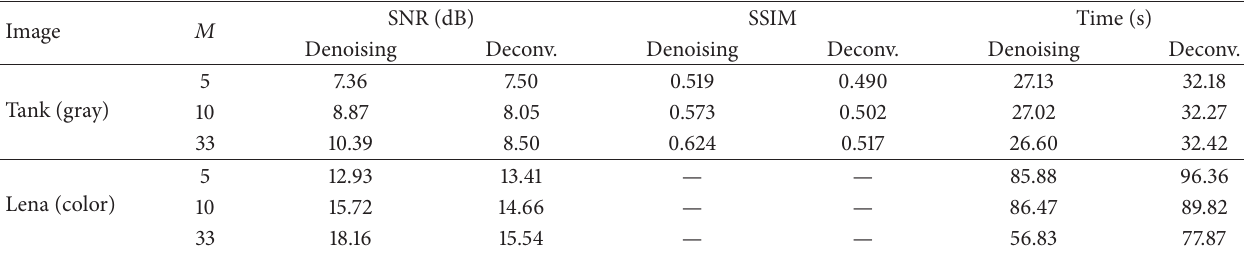
Table 4: Denoising and deconvolution performance results for the Gamma-TV method for the grayscale “Tank” ( 512 × 512 ) image and the color “Lena” ( 512 × 512 )